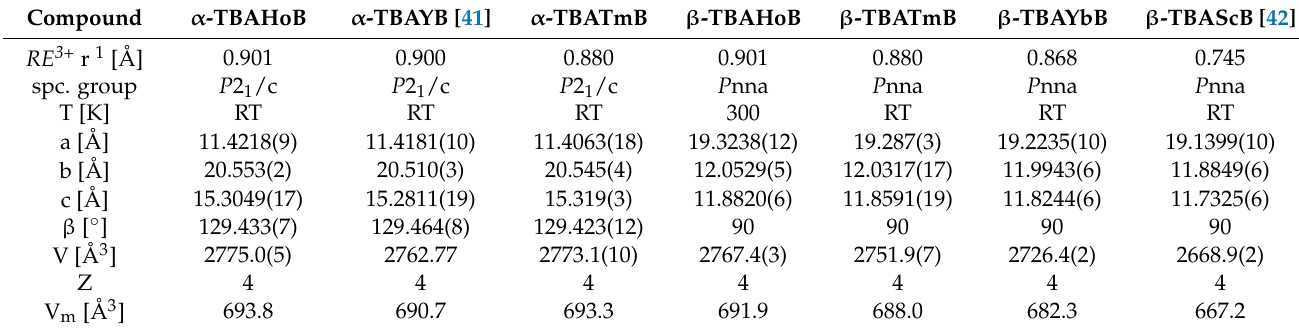
Table 2. Unit cell dimensions for TBA RE B, RE = Y, Ho, Tm, Yb, Sc. Data for 300 K were obtained from SC-XRD, data for RT (ca. 293 K) were obtained from